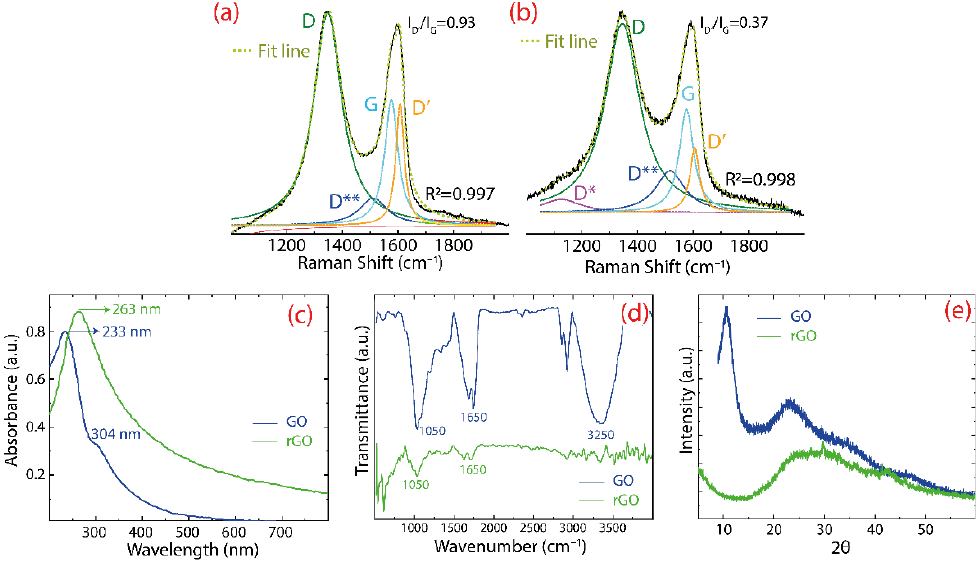
Figure 3. Raman spectra recorded in the 1000–2000 cm − 1 wavenumber region for ( a ) GO and ( b ) rGO. The intensity was normalized by the D peak and the fitting was made by using Lorentzian functions. Spectroscopic characterization of GO and rGO: ( c ) UV–visible (UV-vis), ( d ) IR spectra, and ( e ) XRD analysis.